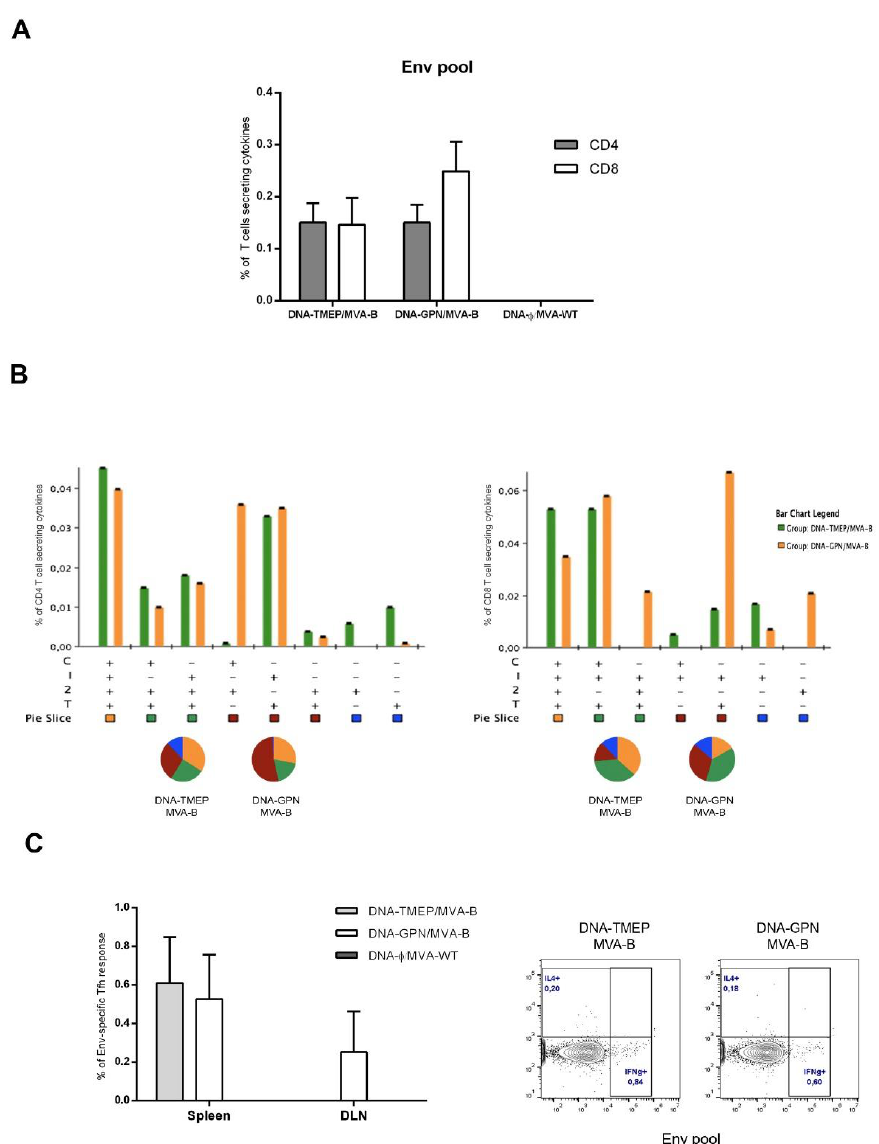
Figure 4. Env-specific T cell immune responses (CD4, CD8, and Tfh) elicited in spleen and DLNs after prime/boost immunization of mice with TMEP-B construct and MVA-B virus. ( A ) Magnitude of the Env-specific CD4 or CD8 T cell immune responses measured at 10 days post-boost by ICS assay after stimulation of splenocytes from immunized animals with HIV-1 clade B Env peptide pool. The total value in each group indicates the sum of the percentages of CD4 + or CD8 + T cells secreting CD107a and/or IFN- γ and/or IL-2 and/or TNF- α against Env peptide pool. Data are background subtracted. ( B ) Functional profile of the Env-specific CD4 (left panel) or CD8 (right panel) T cell responses in the different immunization groups. Positive combinations of the responses are represented on the x axis, whereas the percentages of the functionally distinct cell populations within the total CD4 or CD8 T cells are shown on the y axis. Responses are grouped and colour-coded based on the number of functions. Non-specific responses obtained in the control groups were subtracted in all populations. C: CD107a; I: IFN- γ ; 2: IL-2; T: TNF- α . ( C , left panel) Magnitude of the Env-specific Tfh cells in spleen and DLNs measured as in ( A ). The total value in each group indicates the sum of the percentages of Tfh + T cells secreting IL-4 and/or IFN- γ against Env pool. Data are background subtracted. ( C , right panel) Flow cytometry profiles of vaccine-induced Tfh cell responses in spleen against Env pool in the groups immunized with the heterologous combinations